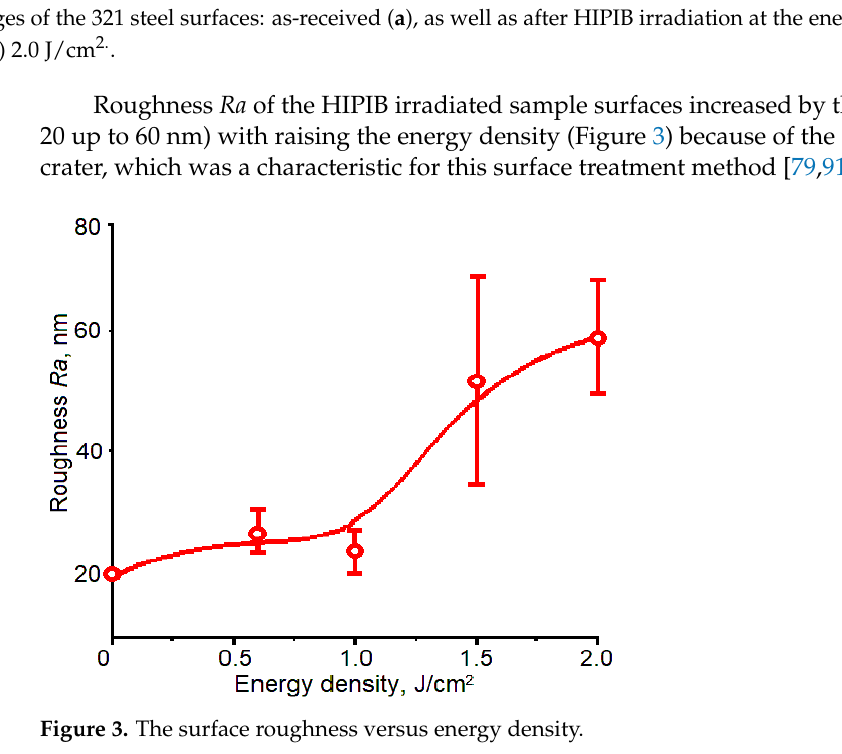
Figure 3. The surface roughness versus energy density.